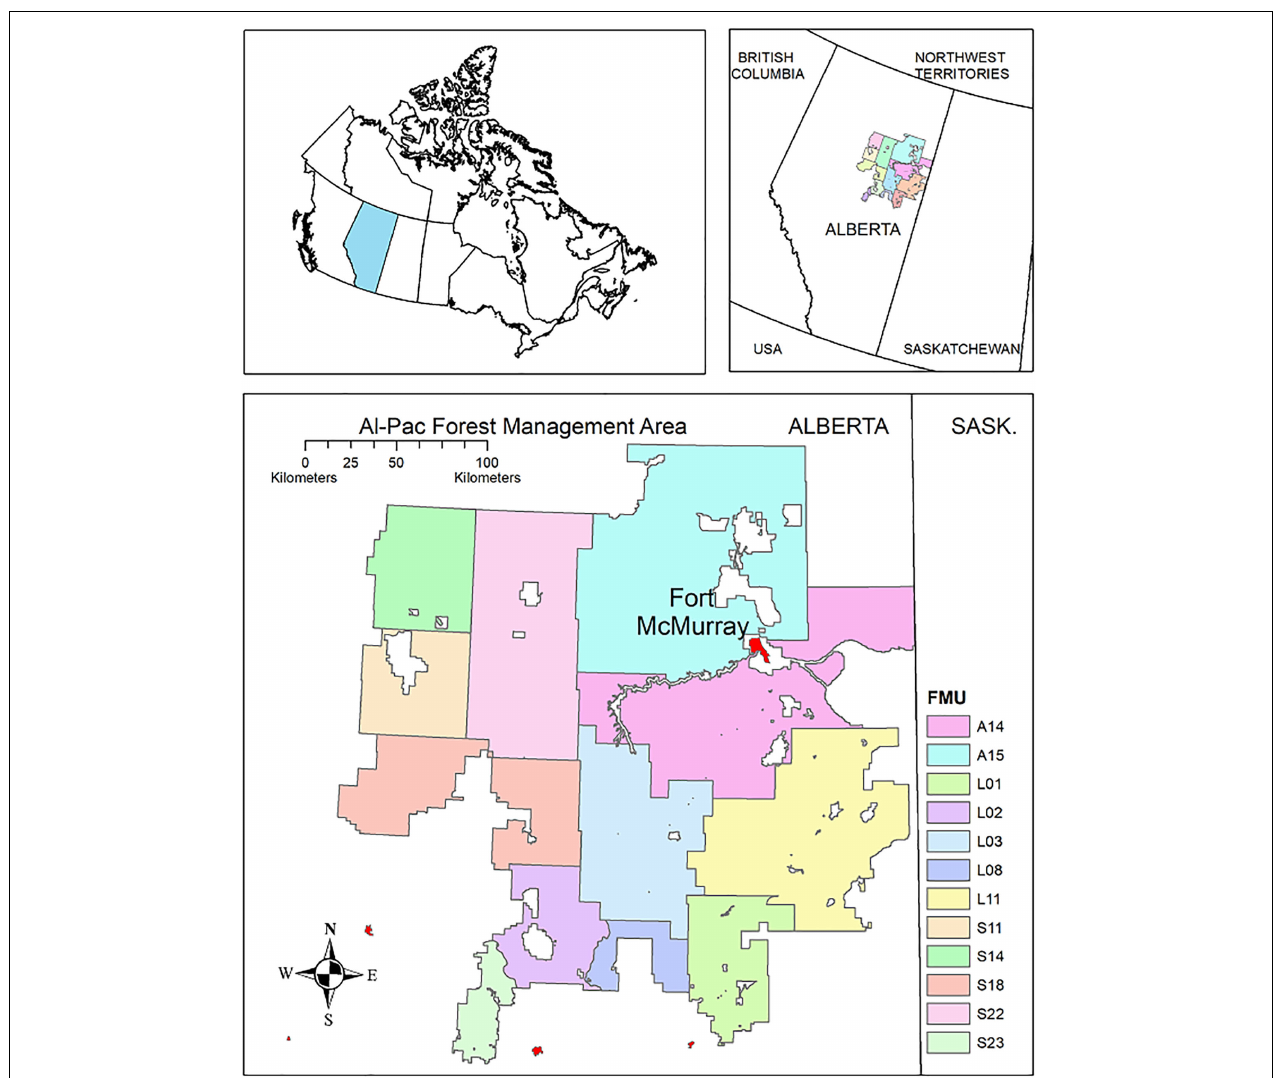
FIGURE 1 | Study area, in the Al-Pac Forest Management Area (FMA) area in northeastern Alberta. There is one Forest Management Plan for the FMA, but the FMA is divided into 12 Forest Management Units (FMUs). Separate harvest targets are set for individual FMUs within the plan, and FMUs vary in size and the amount of habitat for individual bird